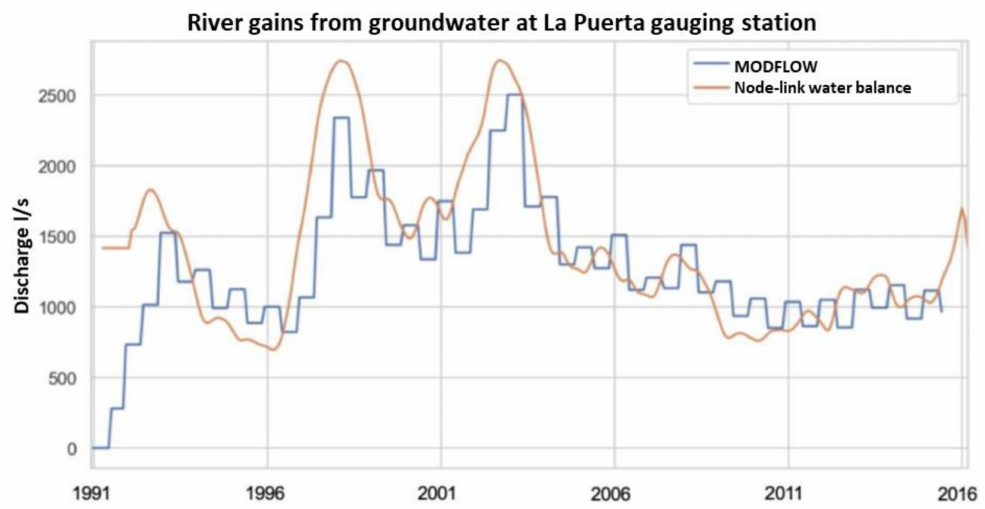
Figure 7. Validation of coupling process for daily surface water mass balance models and groundwa- ter model at “Rio Copiap ó en La Puerta” gauging